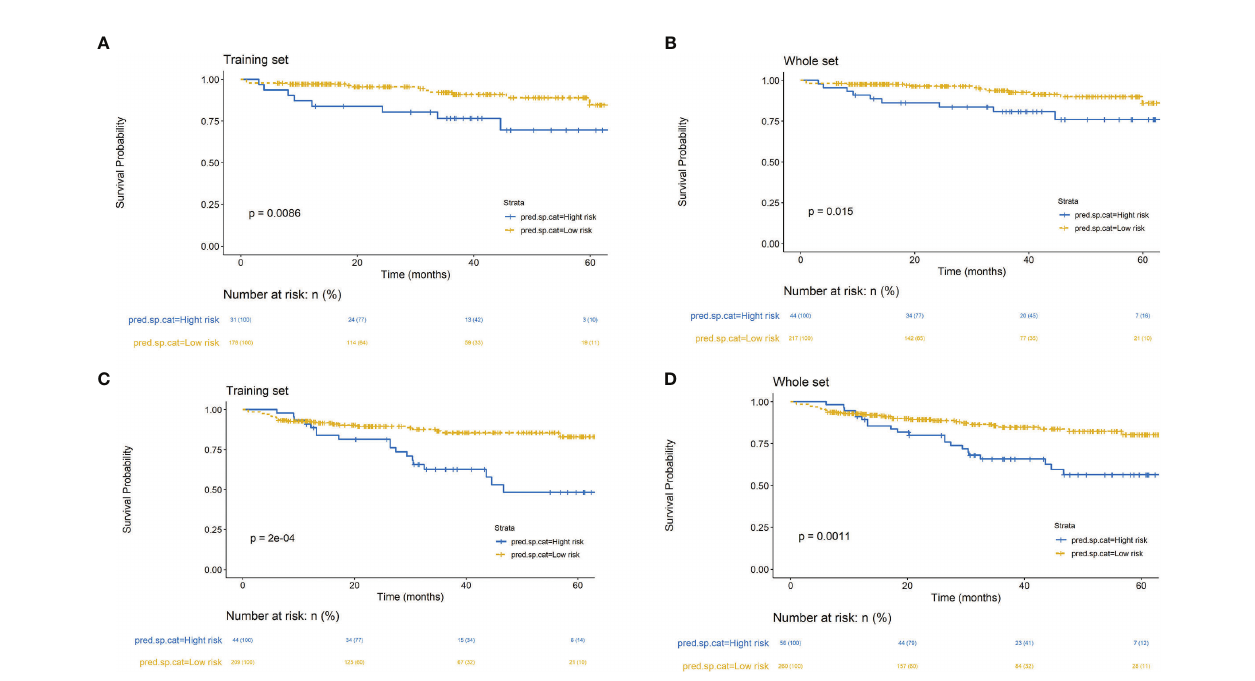
FIGURE 3 | Kaplan-Meier survival curves of risk groups strati fi ed based on the nomogram for LSCC training set (A) and whole set (B) . Kaplan-Meier survival curves of risk groups strati fi ed based on the nomogram for RSCC training set (C) and whole set (D)